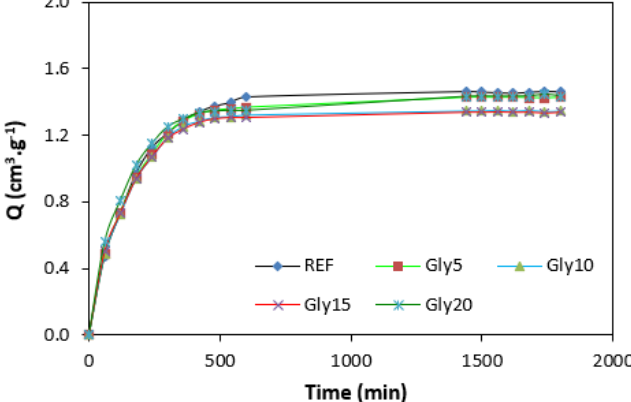
Figure 10. Swelling indexes of vulcanizates NBR-L30.